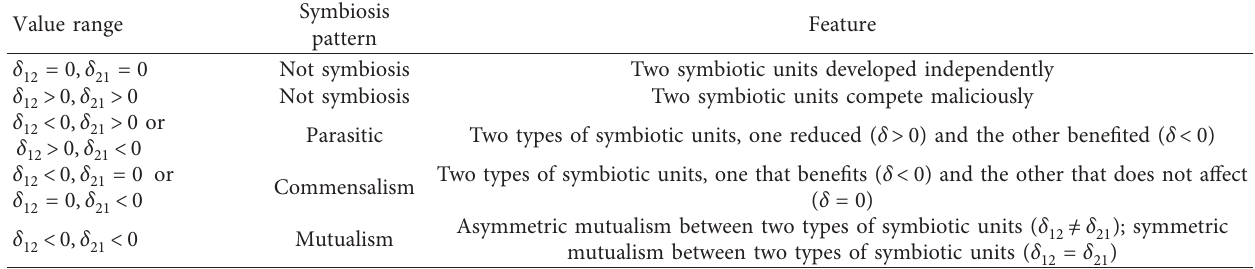
Table 1: The value range of the symbiosis coefficient and its corresponding symbiosis pattern. δ scale change of population 2 on the growth of population 1.